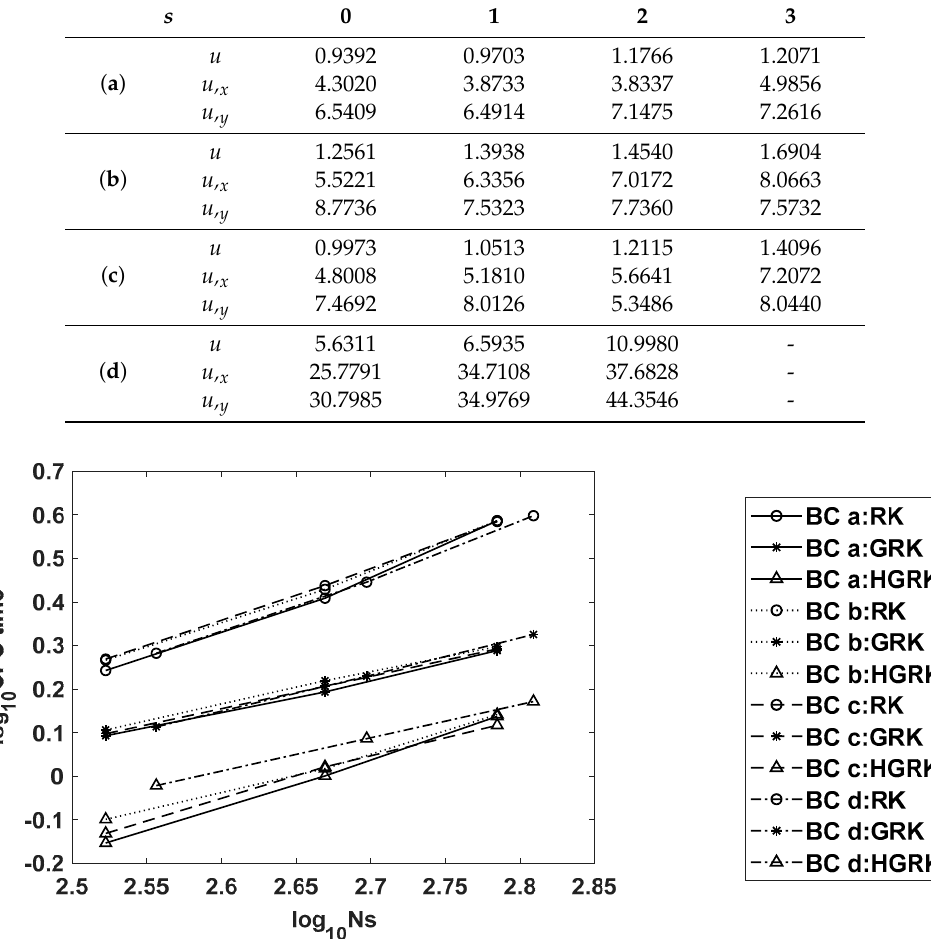
Table 3. Comparison of maximal absolute errors (%) obtained by various s : (a) unknown upper inner boundary; (b) three half unknown inner boundaries; (c) unknown inner boundaries; (d) half unknown outer boundary.